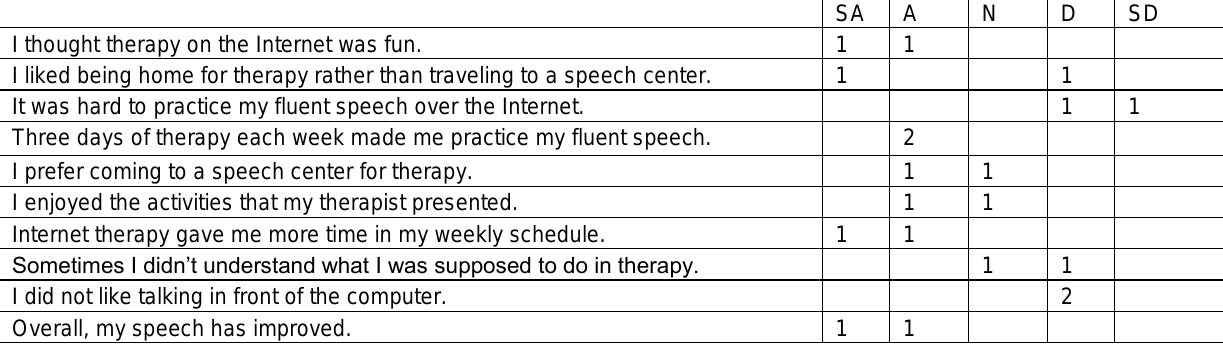
Table 2. Participants’ Perceptions of Telepractice Experience